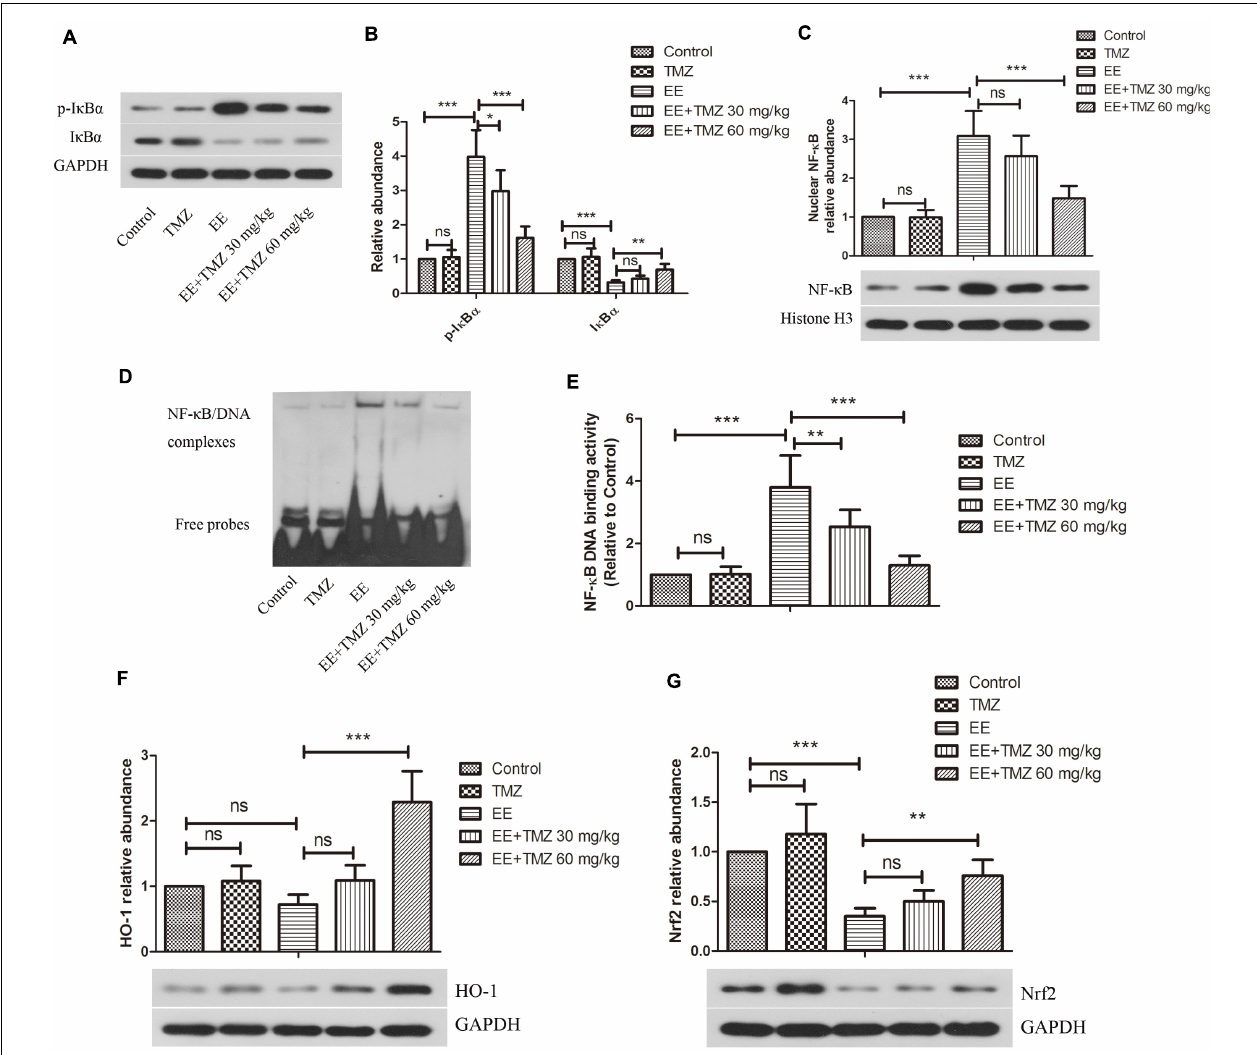
FIGURE 7 | Trimetazidine restrained EE-induced activation of NF- κ B and inactivation of HO-1/Nrf2 signaling pathways. (A–C) Western blot analysis of the protein levels of nuclear factor of kappa light polypeptide gene enhancer in B-cells inhibitor alpha (I κ B α ), P-I κ B α , and nuclear factor kappa-light-chain-enhancer of activated B-cells (NF- κ B) in myocardial tissues. GAPDH and Histone H3 were used as loading controls. (D,E) The DNA binding activity of NF- κ B was evaluated by EMSA assay. (F–G) Western blot analysis of the protein levels of heme oxygenase 1 (HO-1) and nuclear factor (erythroid-derived 2)-like 2 (Nrf2) in myocardial tissues. Each value is shown as mean ± SD ( n = 6). ∗ P < 0.05, ∗∗ P < 0.01, ∗∗∗ P < 0.001, versus the indicated